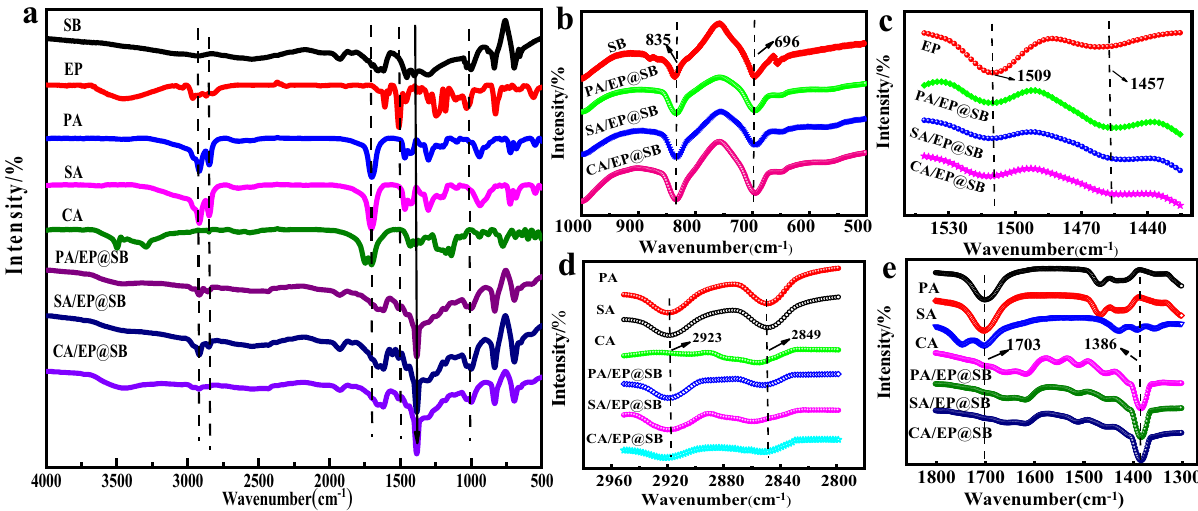
Figure 1: ( a ) FT - IR spectra of the pure SB, PA, SA, CA, EP, PA/EP@SB, SA/EP@SB, and CA/EP@SB, ( b – e ) were the locally enlarged graph of graph ( a )